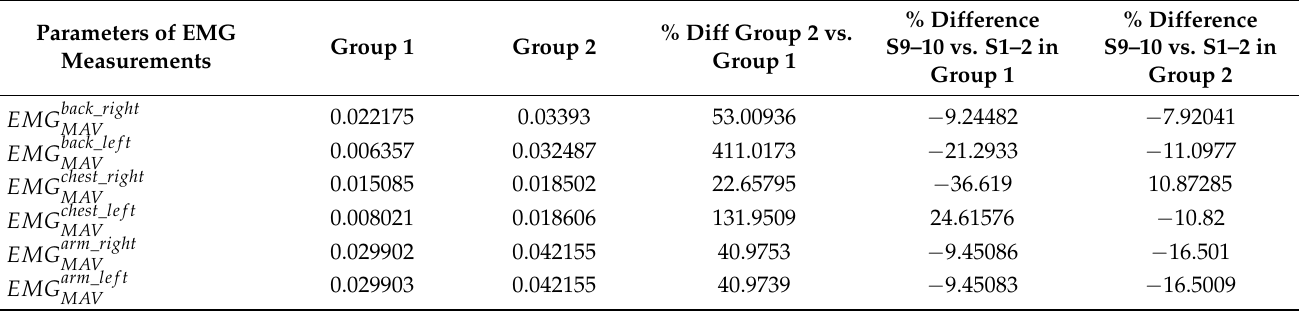
Table 3. Analysis of EEG.